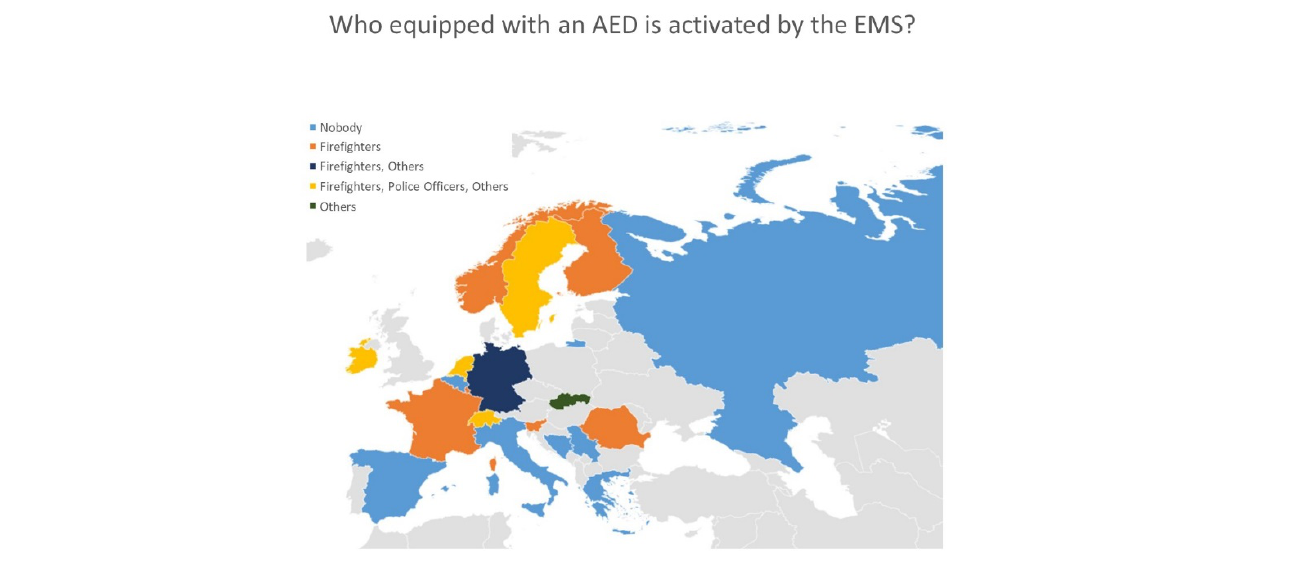
Figure 1. Graphical representation across the different European countries regarding who is, equipped with an AED, activated by the EMS, if there was an AED mapping system and who is allowed to use an AED.